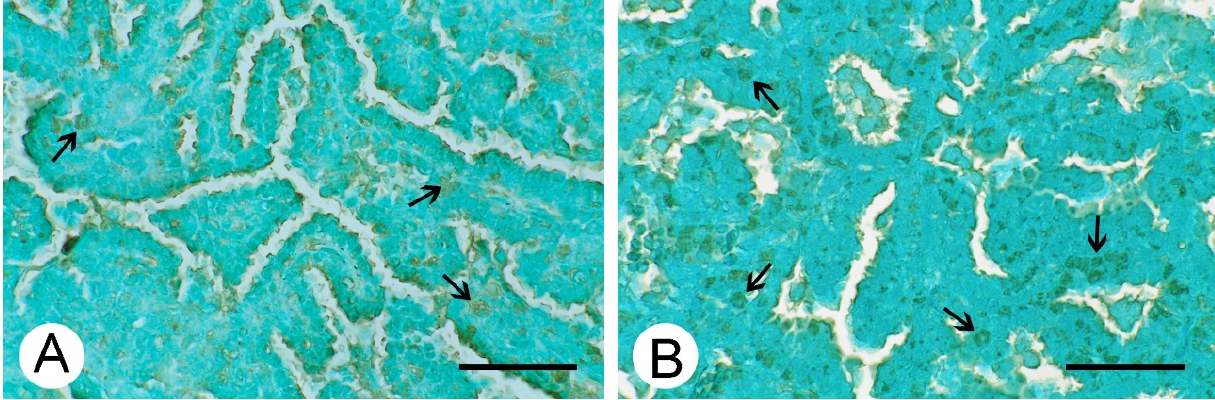
Figure 8. TUNEL immuno-essay. Positive nuclei TUNEL stain (ochre color) were observed in urethane group ( A ) and urethane-V group ( B ) ( ↑ ). Light green counterstain. Bar 50 µm